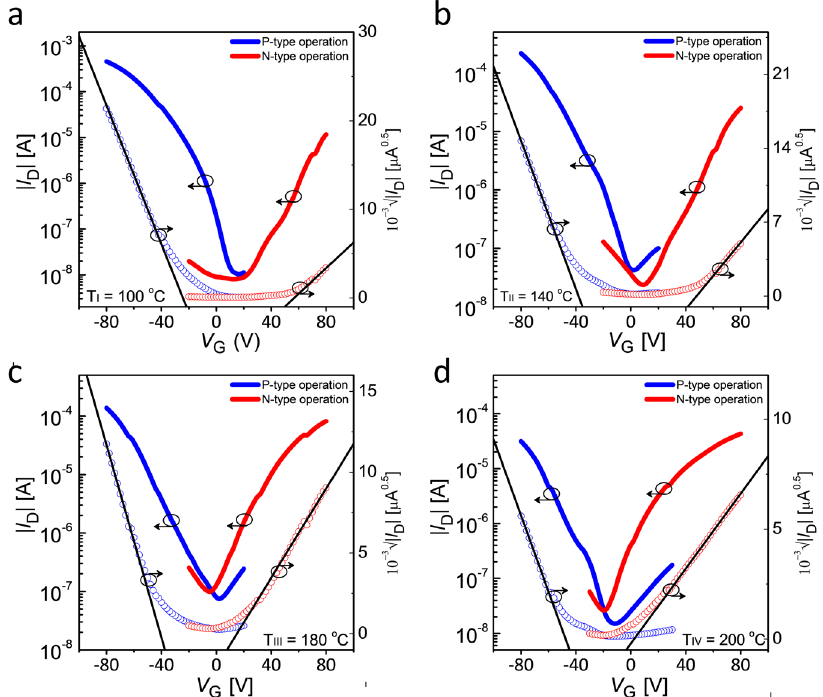
Figure 7. Electrical transfer characteristics of PDPP3T split-gate ambipolar TFTs depending on vacuum annealing condition. ( a ) Measured transfer characteristics at ( a ) T I = 100 °C. ( b ) T II = 140 °C. ( c ) T III = 180 °C. ( d ) T IV = 200 °C. Unipolar p-type operation at V D , V SIDE = − 60 V. Unipolar n-type operation at V D, V SIDE = 60